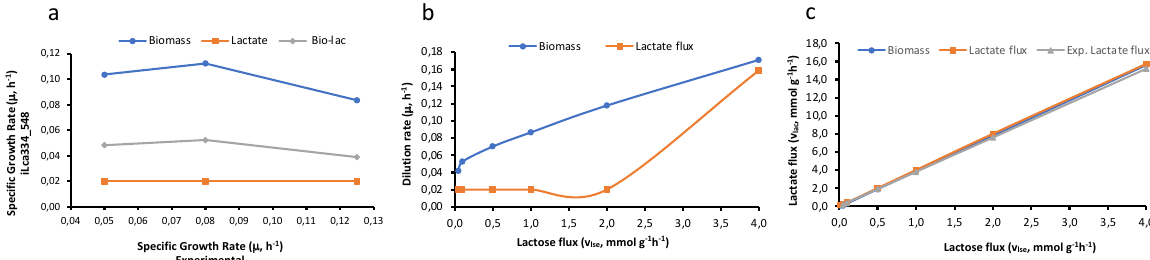
Figure 1. Selection of the objective function. a) Modelled specific growth rate (SGR) on the i Lca334 model against experimental SGR of Lacticaseibacillus paracasei at different dilution rates and evaluation of different objective functions. b) The effect of lactose fluxes on biomass and lactate flux on the i Lca334_548 model. c) The effect of change in lactose flux on the objective functions evaluated. C: N ratio of 5: 1 and dilution rates: 0.05, 0.08, 0.125 and 0.20 h −1 . Bio-lac: Biomass and lactate flux. Exp.: